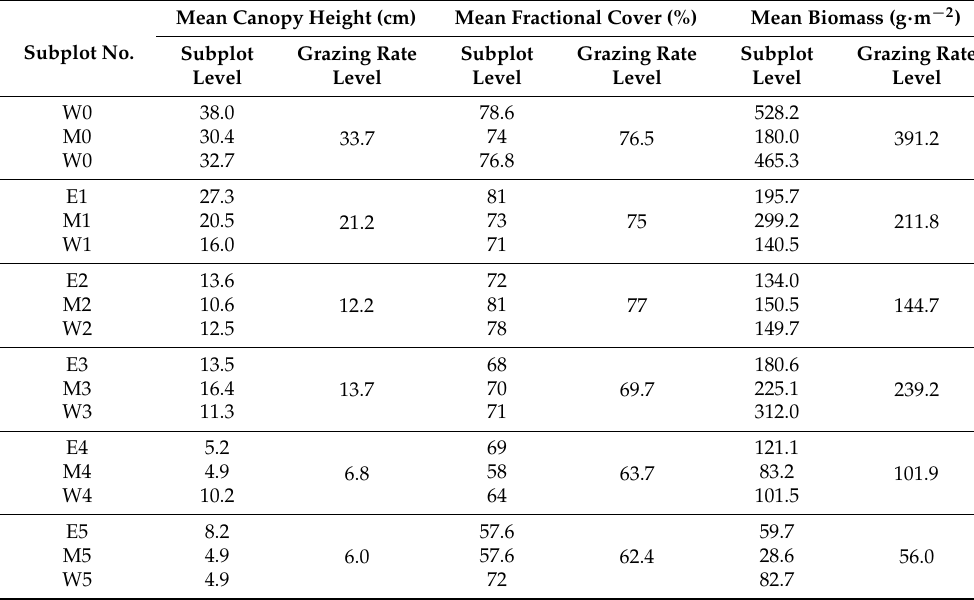
Figure 2. ( a ) Location of Inner Mongolia, China and the study site in Inner Mongolia; ( b ) cattle-grazing plot comprising 18 canopy subplots. W0 to W5, M0 to M5, and E0 to E5 indicate West, Middle, and East replicates of the six stocking rates (0–5); ( c ) location of mult-height survey; and ( d ) one of the randomly selected quadrats. Table 1. Summary of average subplot characteristics.